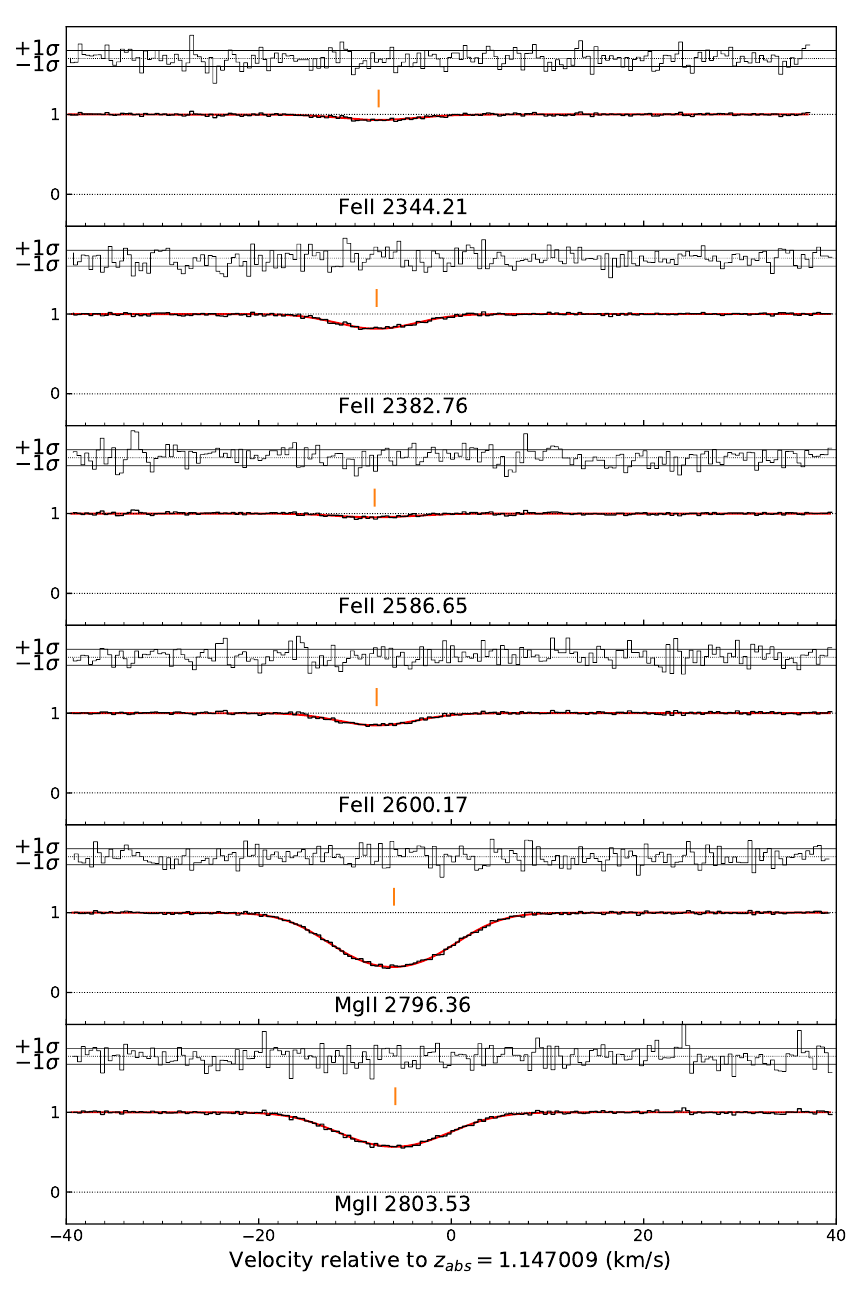
Figure 1. The data (black histogram) in this plot corresponds to the upper panel labelled “Generating model” in Table 1. The model (continuous red curve) corresponds to the middle panel labelled “Fitting (compound)”. See Section